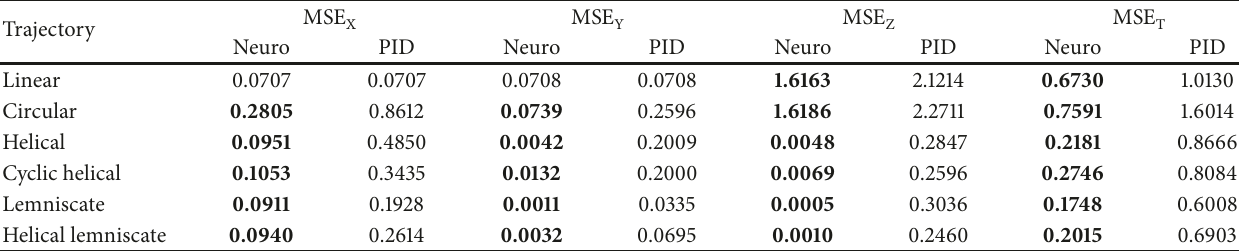
Table 5: Comparison of the MSE of the tracking error for different trajectories with wind disturbances.